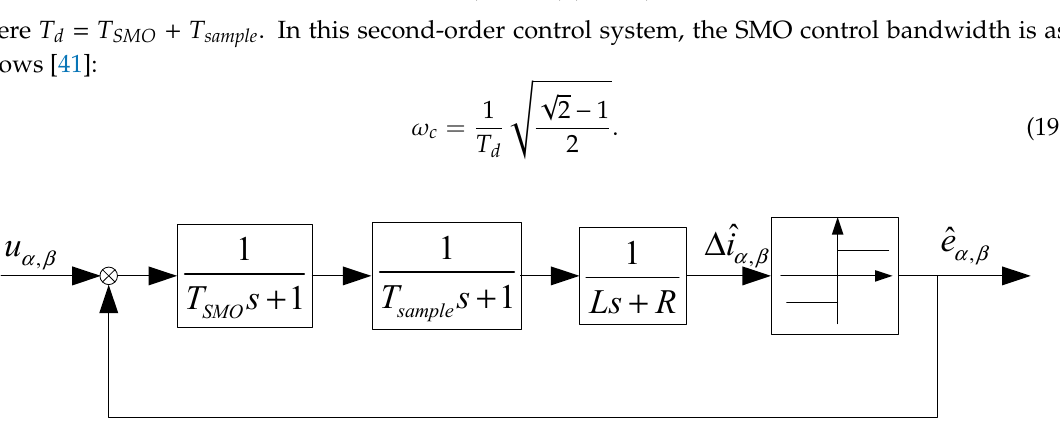
t t Figure 6. Typical sequential of PWM update and SMO sampling.